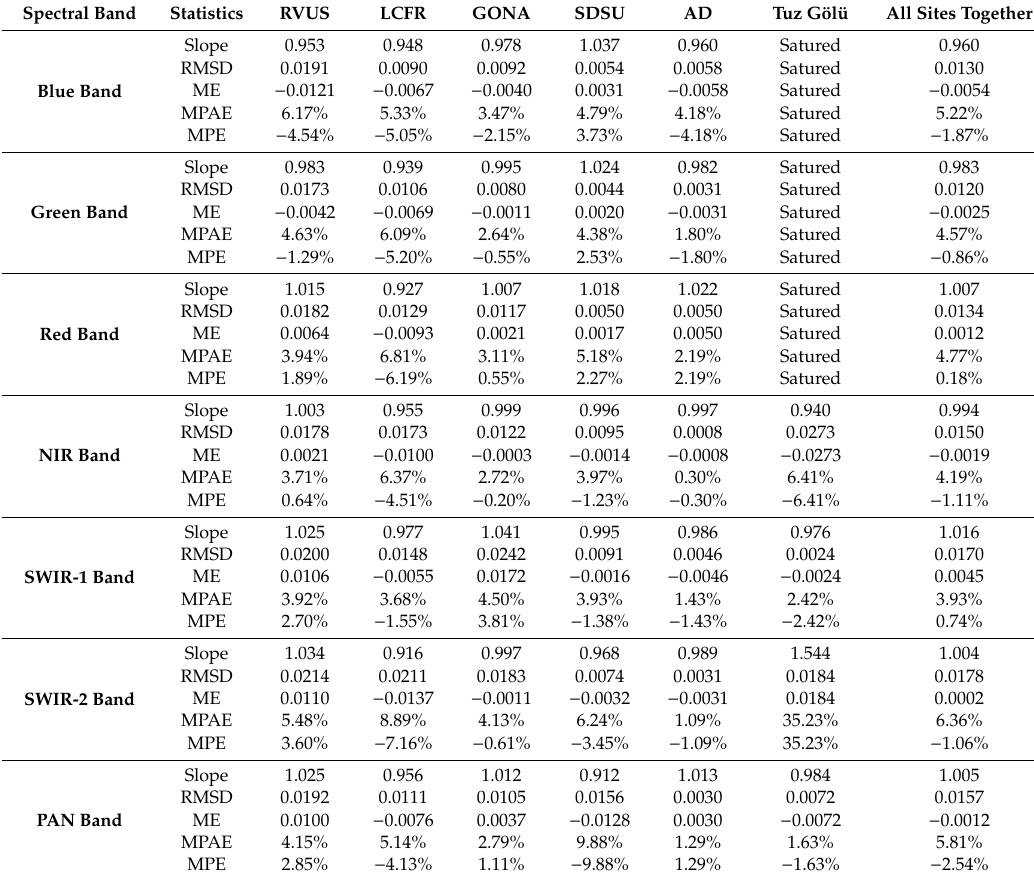
Figure 12. Temporal trends, by band, of residuals errors in TOA reflectance predicted from in situ measurement and Landsat-7 ETM+ Level-1 TOA reflectance data. Table 2. Comparison between TOA reflectance predicted from in situ measurement and Landsat-7 ETM